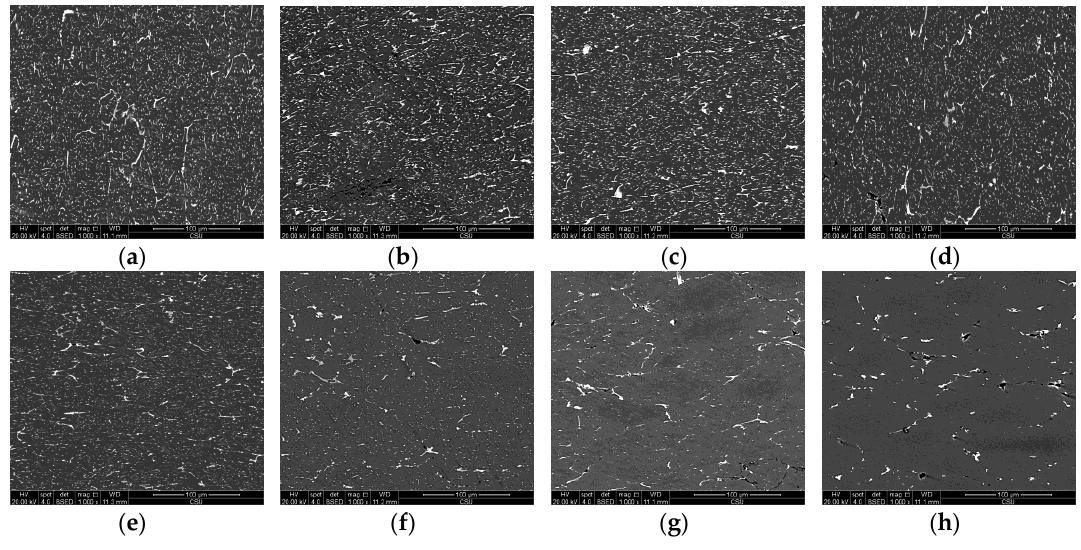
Figure 6. Back-scattered electron SEM images: ( a ) 340 °C, 1 s −1 ; ( b ) 340 °C, 0.001 s −1 ; ( c ) 380 °C, 1 s −1 ; ( d ) 380 °C, 0.001 s −1 ; ( e ) 420 °C, 1 s −1 ; ( f ) 420 °C, 0.001 s −1 ; ( g ) 460 °C, 1 s −1 ; and ( h ) 460 °C, 0.001 s −1 .